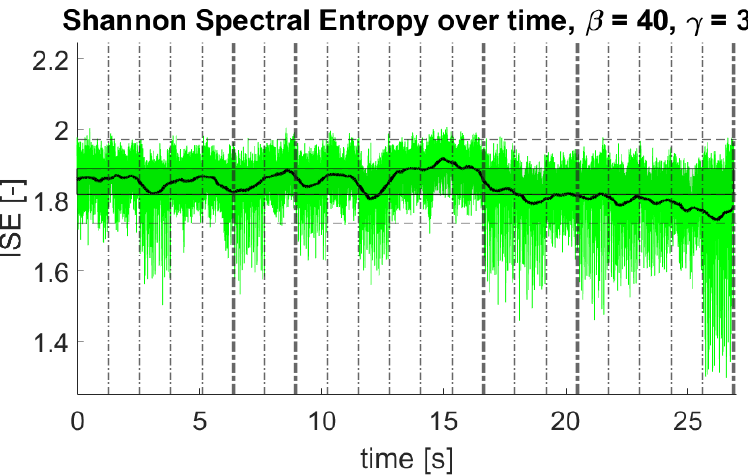
Figure 13. Resulting ISE (signal #2). Values for. 𝛽 = 40 and 𝛾 = 3 .